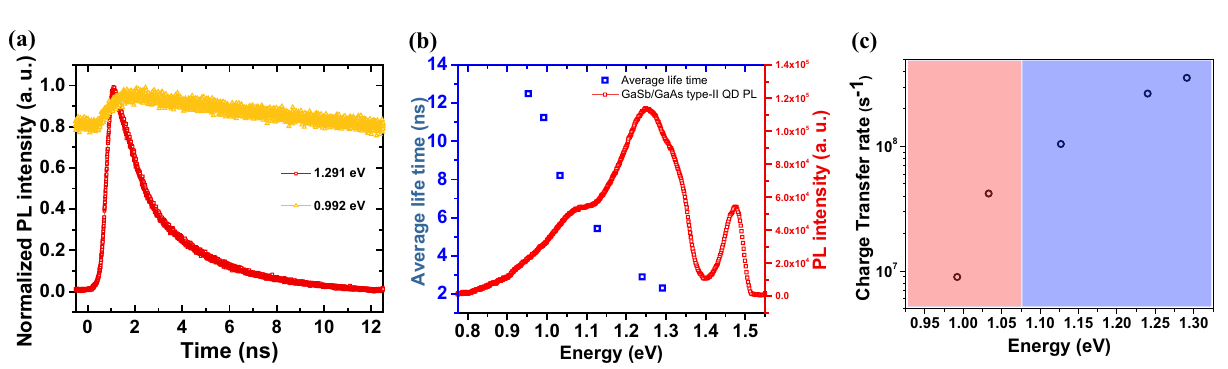
Figure 4. ( a ) Power-dependent PL spectra at 16 K, ( b ) peak energy shift data from the laser power of 1–30 mW, ( c ) temperature-dependent PL spectra from 14 to 300 K, and ( d ) scheme of relaxation processes in self-aligned type-II junction GaSb QD with GaAs capping layer.